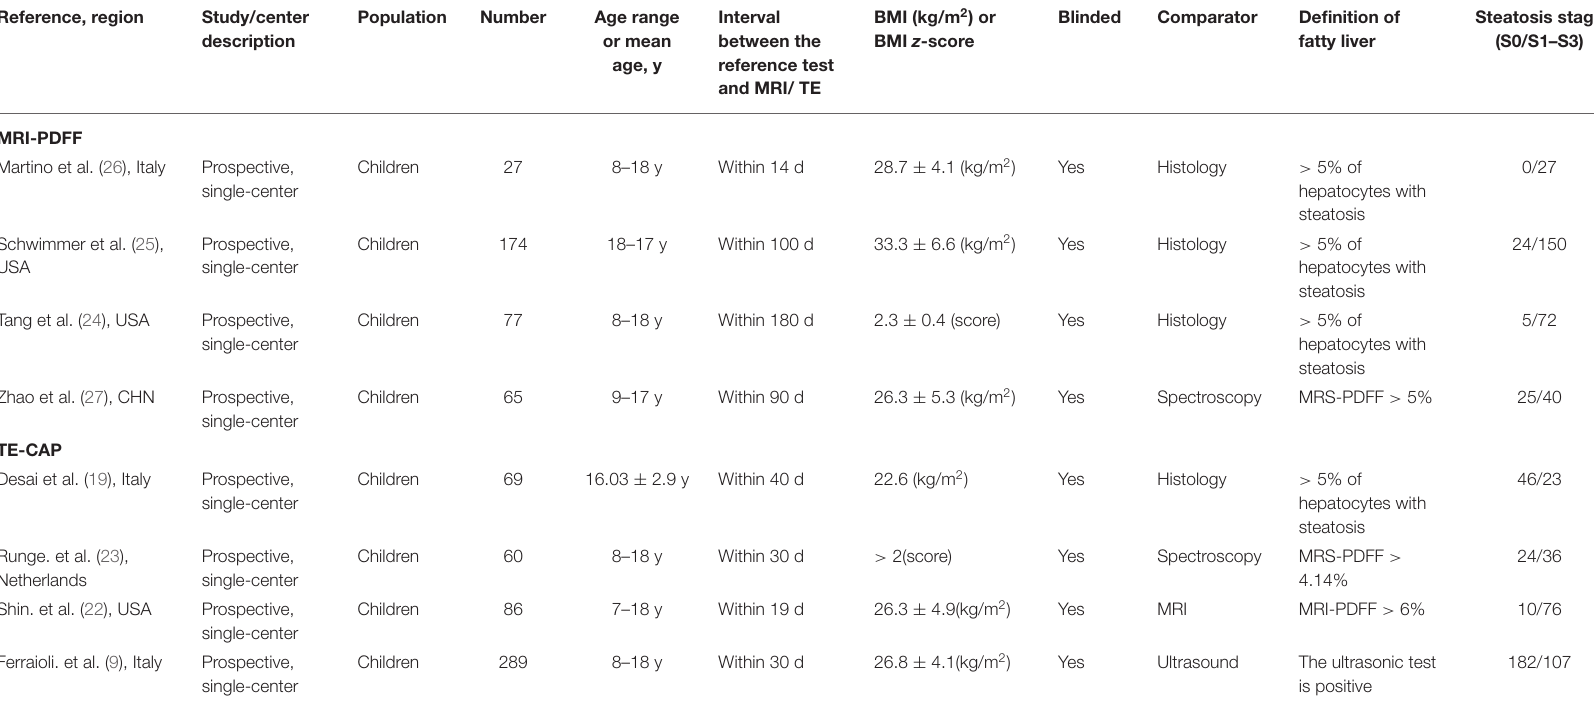
TABLE 1 | Characteristics of the included pediatric studies, comparing imaging-based evaluation of steatosis with a quantitative reference diagnostic test. Reference,